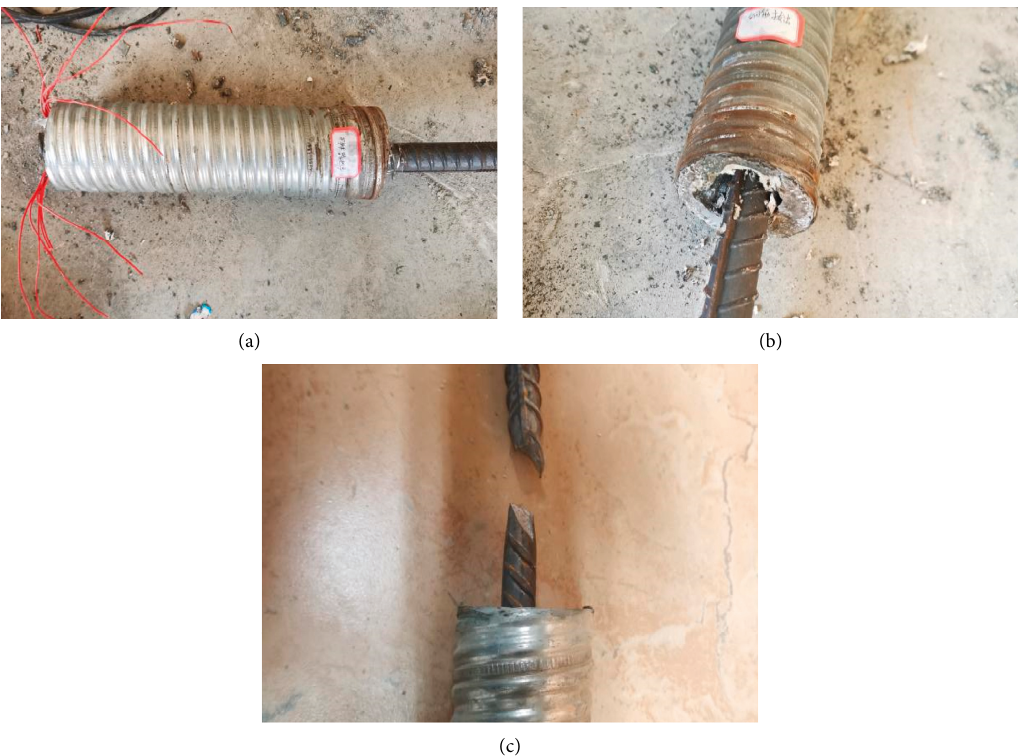
Figure 5: Form of destruction. (a) Test piece pull-out failure diagram. (b) Grout broken diagram. (c) The fracture diagram of the steel bar of the test